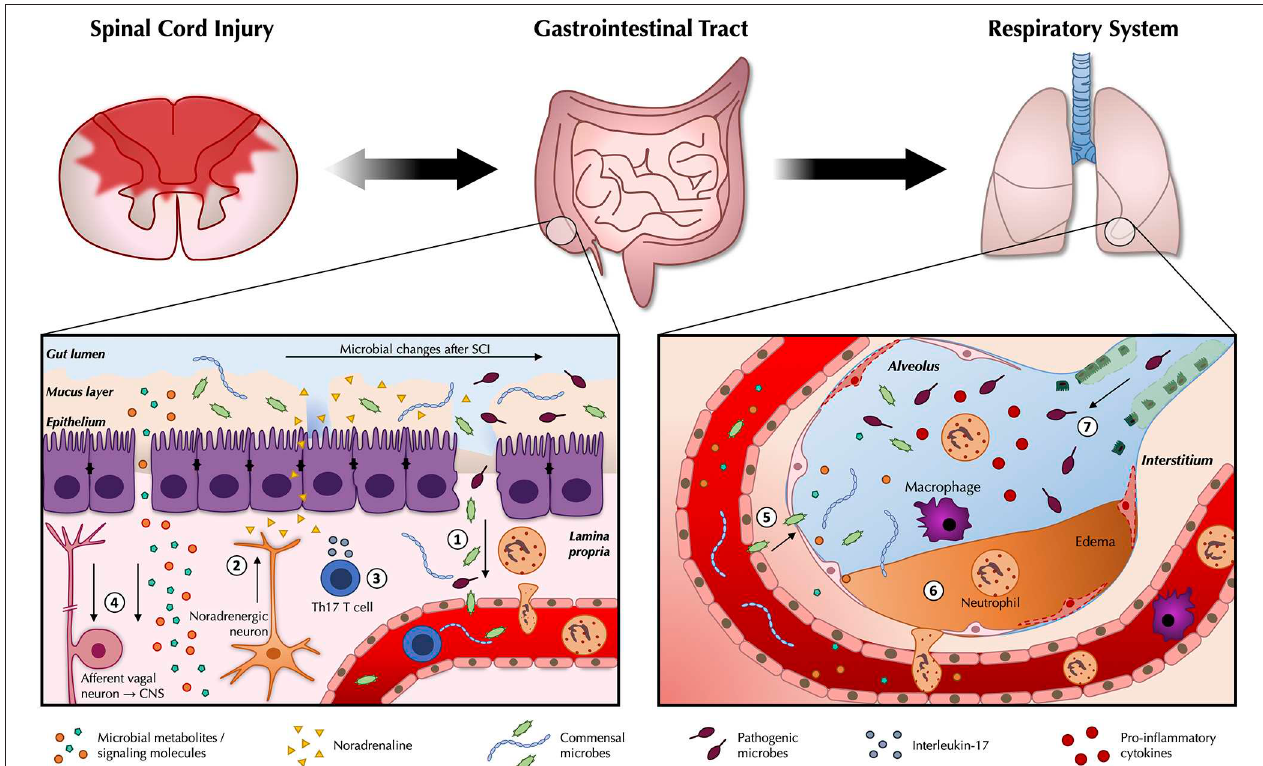
FIGURE 1 | Pathogenic changes in the gut microbiota after traumatic spinal cord injury. As part of the wider systemic response to SCI, inflammatory changes in the gut are likely to contribute to reduced intestinal function and barrier integrity (1). Leakiness of the gut epithelium can dysregulate the microbial community in the gut lumen and allow for bacterial translocation. Release of noradrenaline from post-ganglionic sympathetic terminals is thought to further contribute to gut dysbiosis (2). A greater abundance and/or expansion of specific pathobionts after SCI can induce a Th17 response, which propagates further inflammation (3). Afferent sensory feedback signals report perturbations in the intestinal environment to the brain via the vagus nerve, thereby completing the bidirectional loop between the gut and the central nervous system, while gut microbes release metabolites and signaling molecules such as short-chain fatty acids (SCFAs) that shape peripheral immunomodulatory processes (4). These changes may modulate the immune response to e.g., airway infections. Commensal microbes from the gut may also be able to take up inappropriate residence in the lungs (5). Local inflammatory changes in the lungs in response to SCI may compromise the respiratory epithelium (6), and interfere with local defense mechanisms against extraneous pathogens